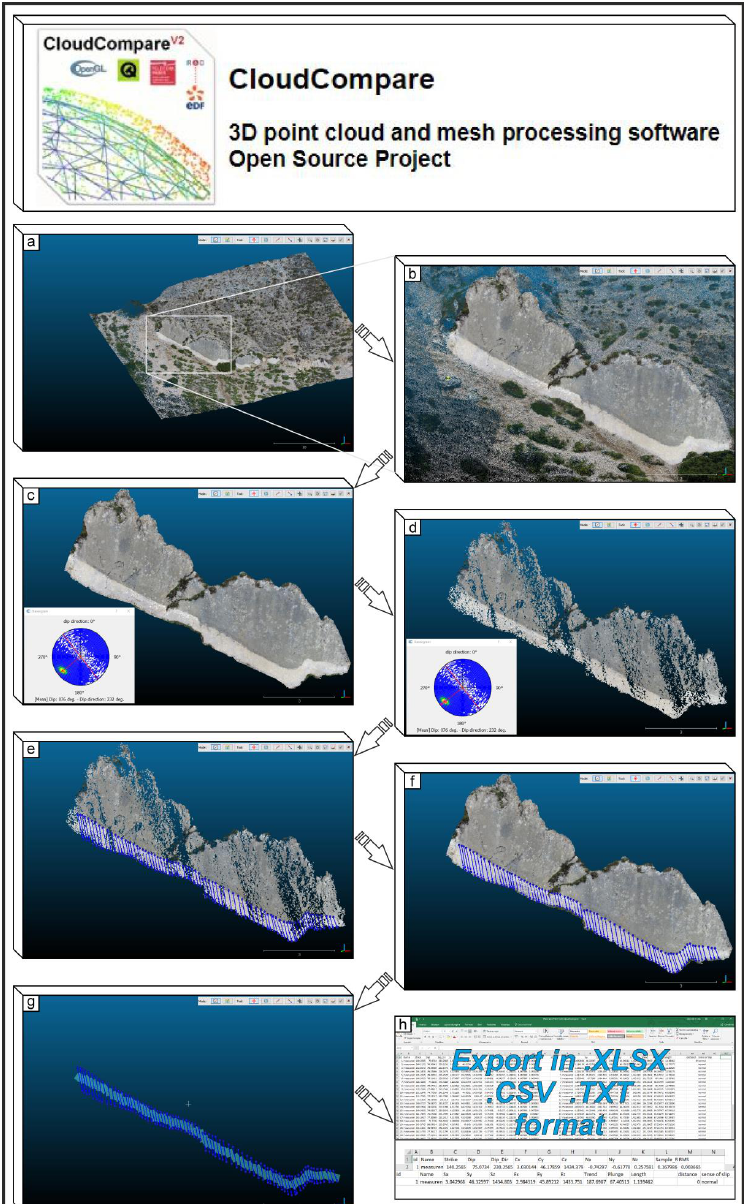
Figure 6. The main steps carried out in Cloud Compare (CC): ( a ) dense-points cloud imported into a CC as ascii file; ( b ) selection of the interest features; ( c ) contour and selection of all the dense-point cloud around the fault plane and extraction, through the plugin qFacets, of all plunge and dip direction in a stereogram; ( d ) from the stereogram the dip directions of the striae, evidenced by grooves, are excluded; ( e , f ) picking of net displacement (mm), striae attitude (trend and plunge), dip direction and dip-ange of the fault plane; ( g ) view of the net displacement and the striae detected on the fault plane; ( h ) export all data in excel, .csv, or .txt